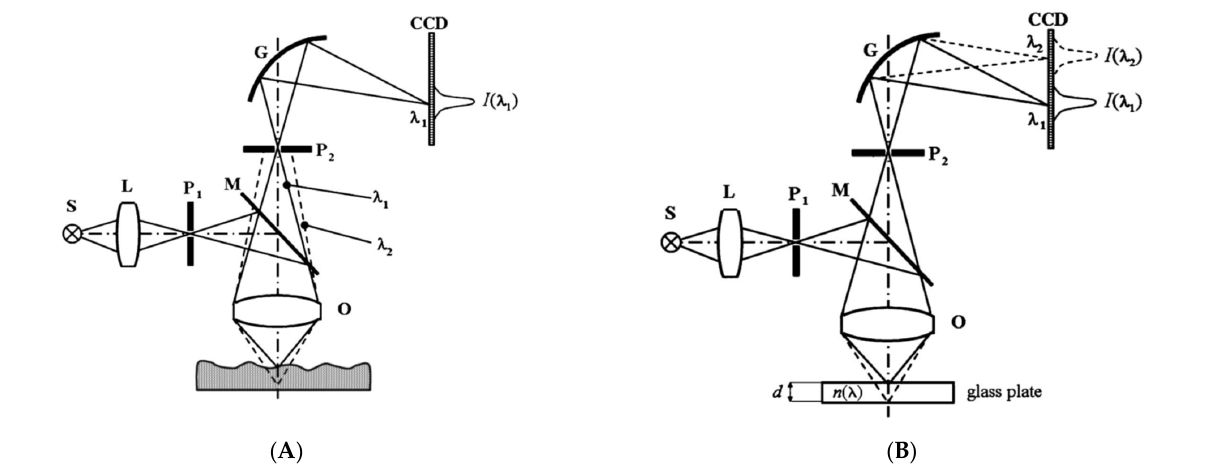
Figure 9. Chromatic confocal microscopy for measuring ( A ) topographic profile and ( B ) a transparent plate thickness (reprinted/adapted with permission from [57] © The Optical Society); S, optical source; L, condenser; P 1,2 , aperture stops; M, beam splitter; O, objective lens; G, grating.